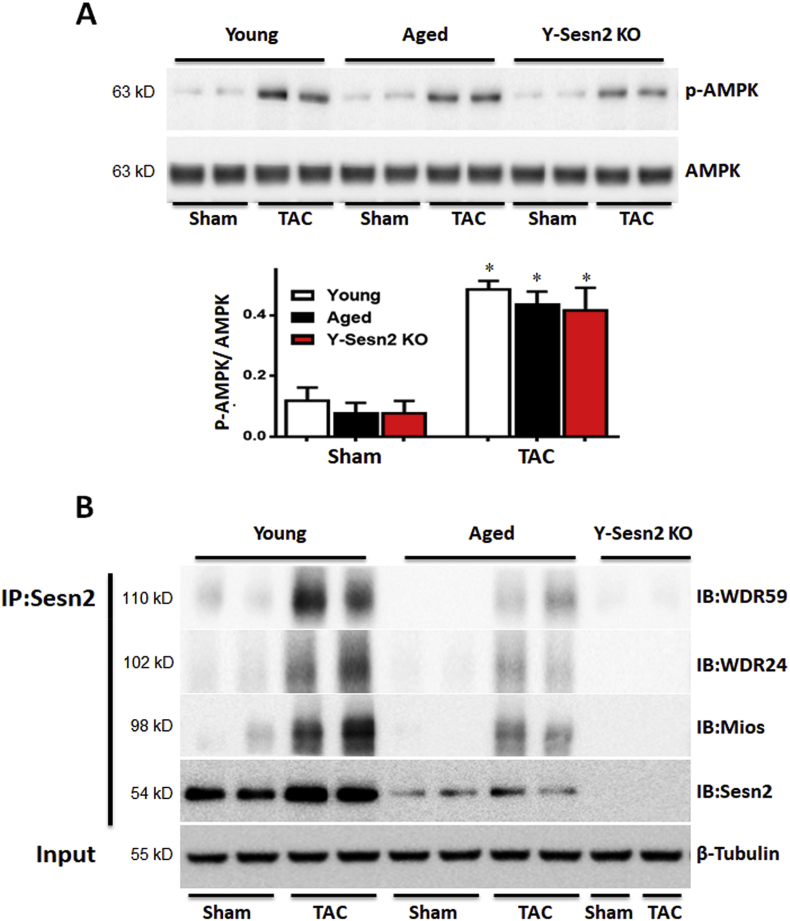
Sesn2 interacts with MIOS, WDR24, and WDR59 of the GATOR2 complex to inhibit mTORC1. (A) Immunoblot for p-AMPK and AMPK proteins from hearts of Y-Sesn2 KO, aged WT(Aged), and young WT (Young) mice at 4 weeks after TAC or sham surgery (n = 6 per group). (B) Heart tissues were harvested from young WT and aged WT mice that had been subjected to TAC or sham surgery. Nuclear extracts were isolated and immunoprecipitated (IP) with anti-Sesn2 antibody, then immunoblotted (IB) with anti-Sesn2, anti-WDR59, anti-WDR24, or anti-MIOS antibodies. Values are mean ± SEM, *p < 0.05 vs. Sham group.